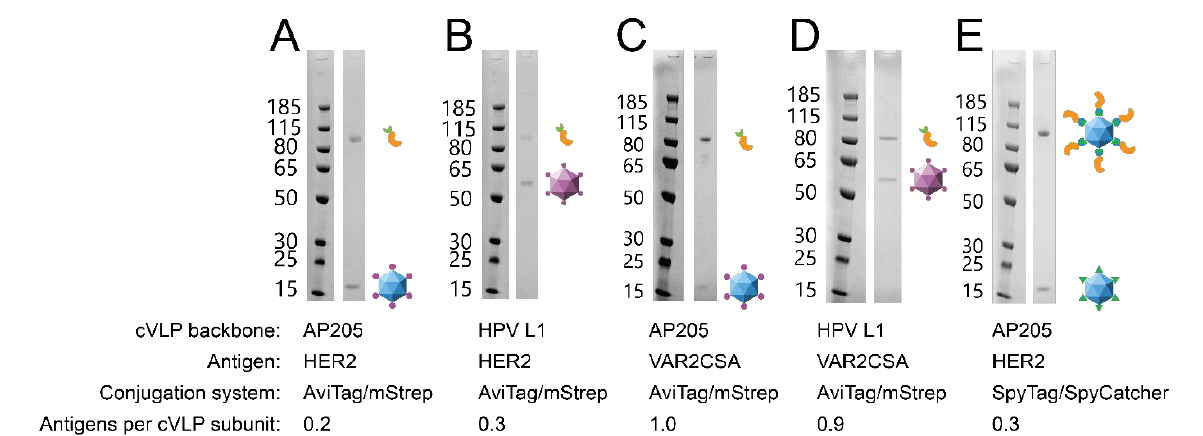
Figure 2. Vaccine coupling efficiency. After purification by ultracentrifugation and dialysis, the coupling efficiency of each vaccine was measured by SDS-PAGE densitometry. During reducing SDS-PAGE, the affinity-based AviTag:mStrep- conjugation is disassembled ( A – D ), while the covalent SpyTag:SpyCatcher-conjugation is maintained ( E ). ( A ) AviTag- AP205:mStrep-HER2. ( B ) AviTag-HPV:mStrep-HER2. ( C ) AviTag-AP205:mStrep-VAR2CSA. ( D ) AviTag-HPV:mStrep- VAR2CSA. ( E ) SpyTag-AP205:SpyCatcher-HER2. The number of antigens per cVLP subunit was calculated based on the relative intensities of protein bands present in each lane (see Supplementary Table S1 for a detailed explanation).